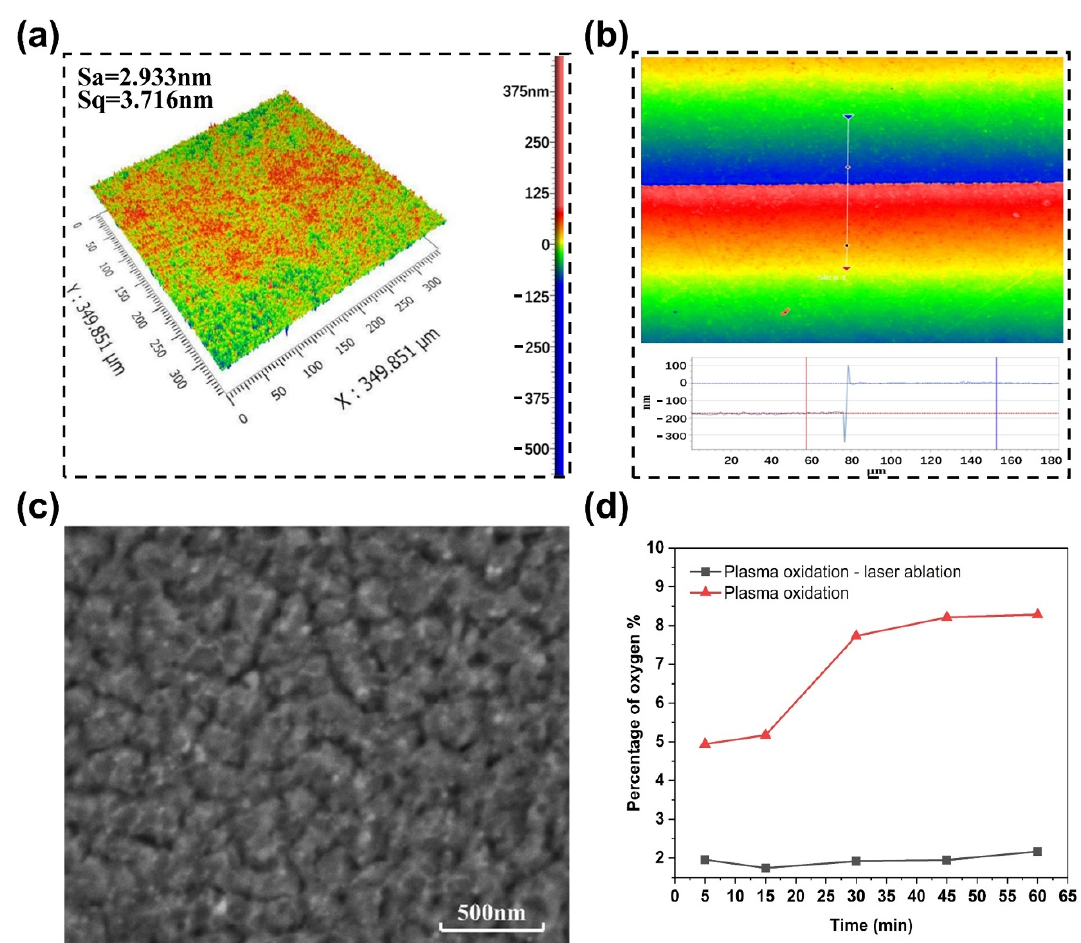
Figure 5. Surface morphology of the Cu film obtained by the hybrid removal process. ( a ) three-dimensional (3D) morphology, ( b ) the boundary between untreated and laser-treated areas, and ( c ) SEM image. ( d ) Evolution of the surface oxygen content.